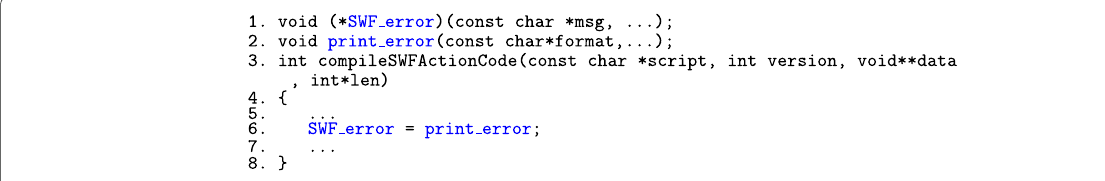
Fig. 5 E.g., definition of global function pointer variable